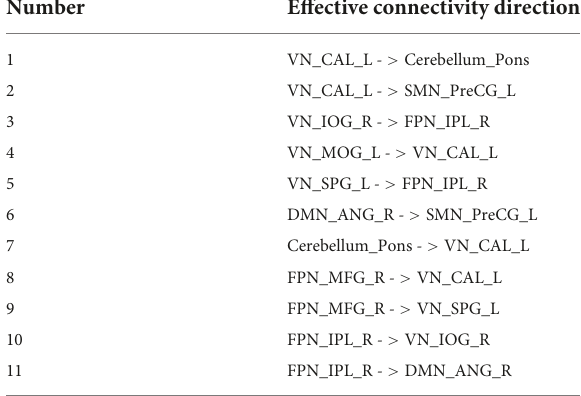
TABLE 3 The different parts of the effective connectivity between the two